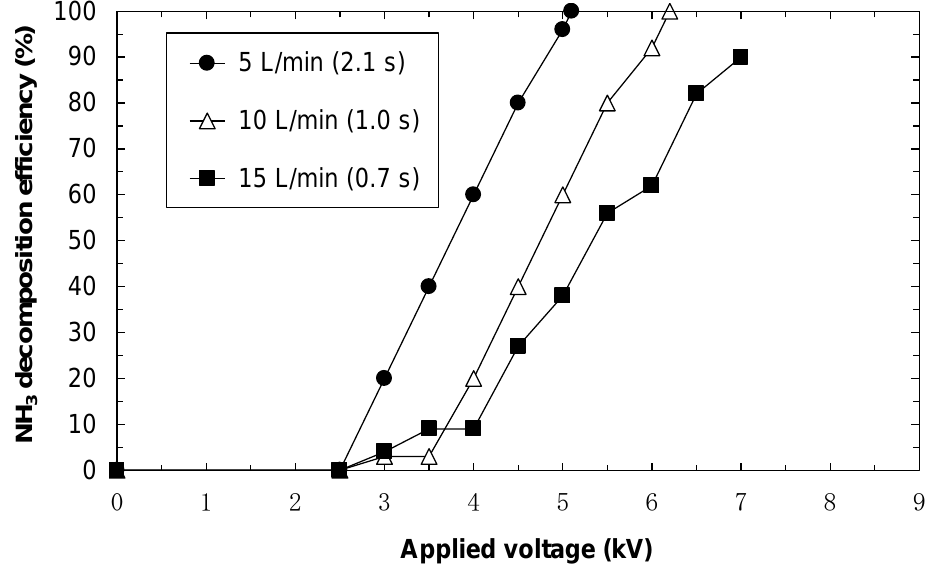
Figure 10. Effect of flow rate on ammonia decomposition (initial concentration = 100 ppm, laminated film-electrode packed-bed plasma